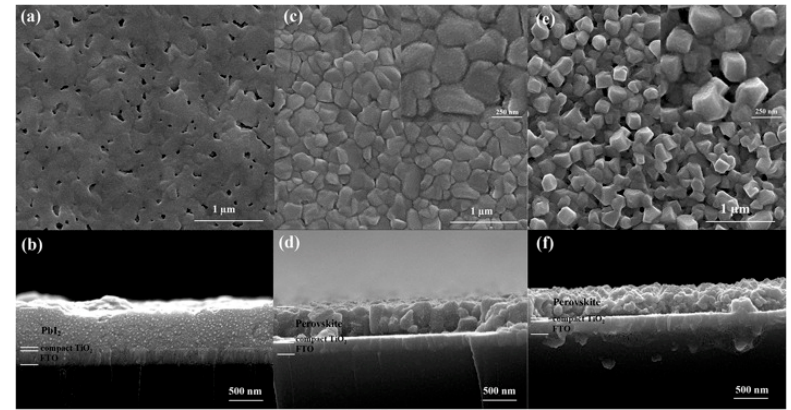
Figure 3. Top-view SEM images of ( a ) PbI 2 ; ( c ) vapor-crystallized perovskite; and ( e ) solution-crystallized perovskite; the insets of c and e show magnified images of perovskite crystals. ( b , d , f ) Corresponding cross-view SEM images of PbI 2 , vapor crystallized perovskite, and solution-crystallized perovskite [54]. Copyright © 2015, American Chemical Society.